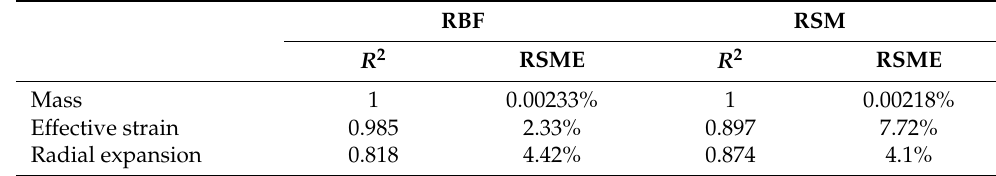
Table 3. The accuracy of the surrogate model.